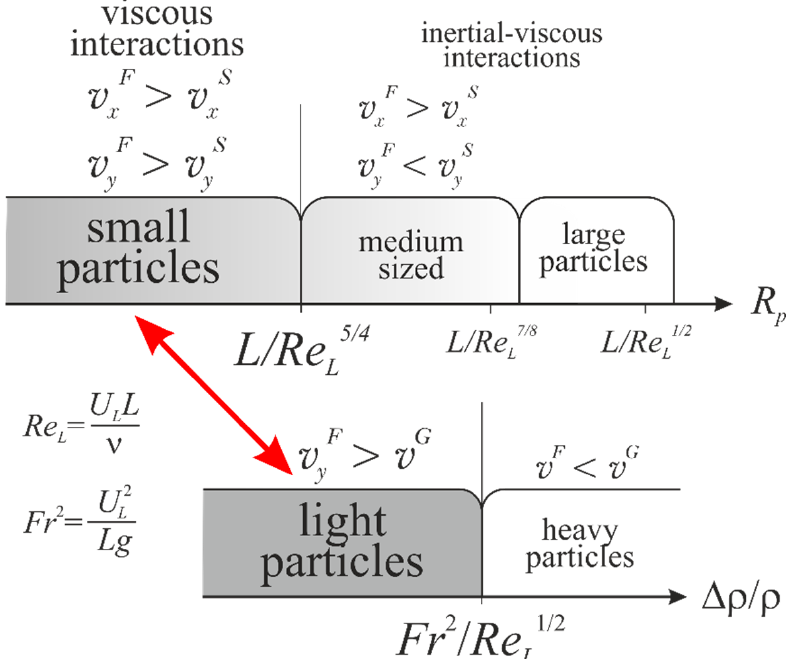
Figure 8. Classification of non-neutrally buoyant particles within the boundary layer at a solid wall; Fr 2 = U L is the Froude number; Re L = LU L is the Reynolds number of the background fluid flow.